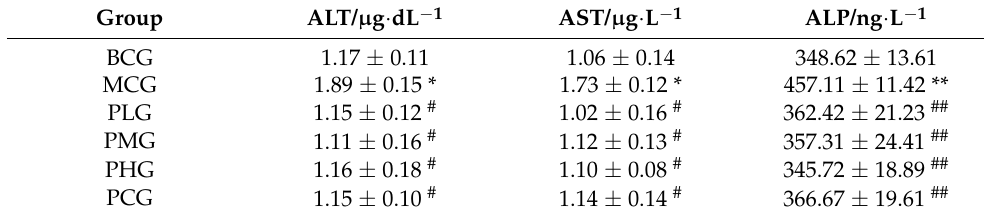
Table 1. Liver function indicators of each group (n = 10, X ± s).